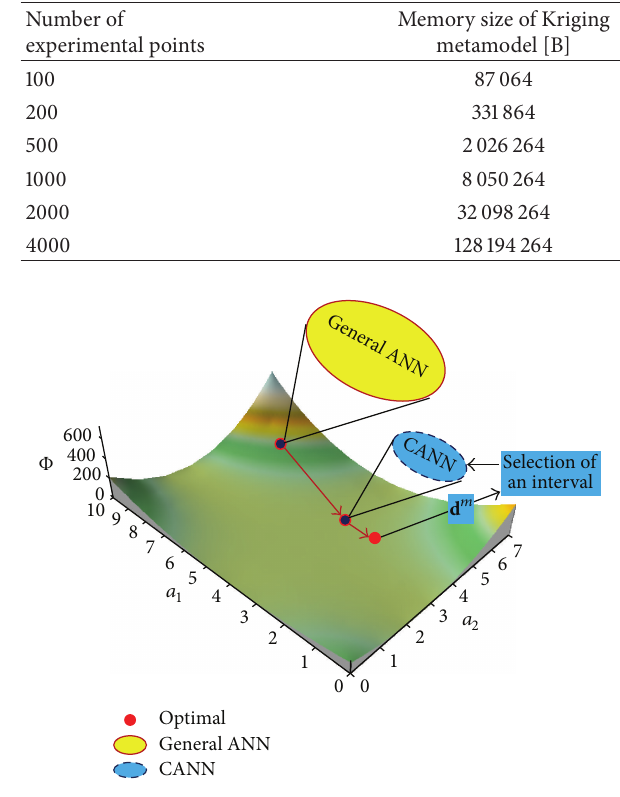
Figure 5: The idea of application of clusterization of the ANN during